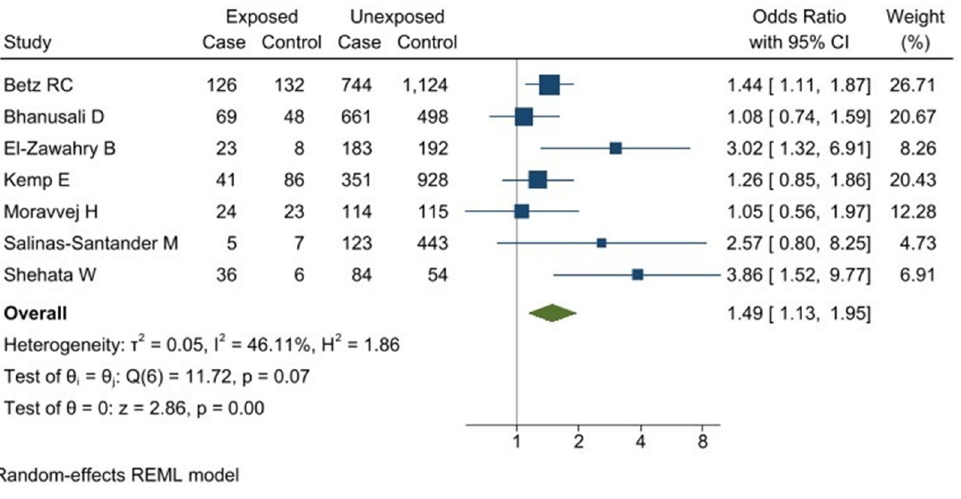
Fig 2. Association between rs2476601 polymorphism of PTPN22 gene and the risk of alopecia areata. Allelic model T vs C. Exposed group: patients with allele T; Unexposed group: patients with allele C .